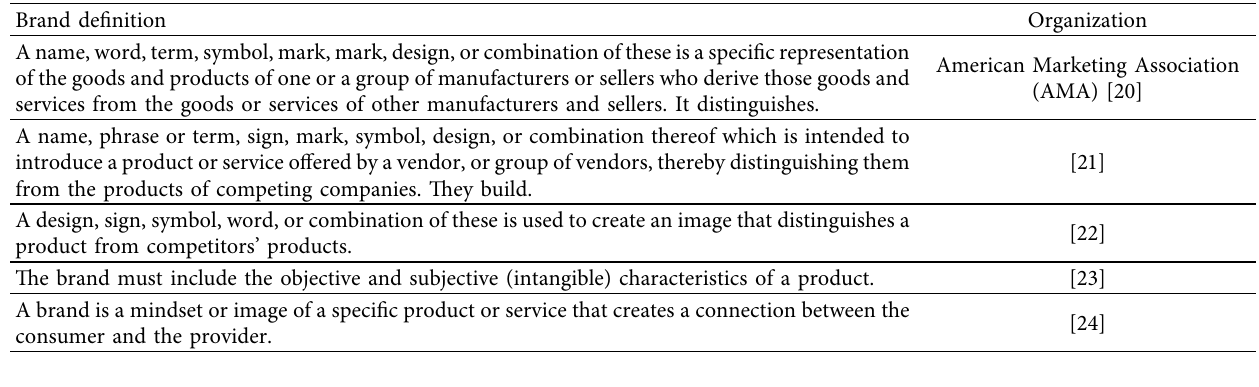
Table 1: Scientific definitions of branding.